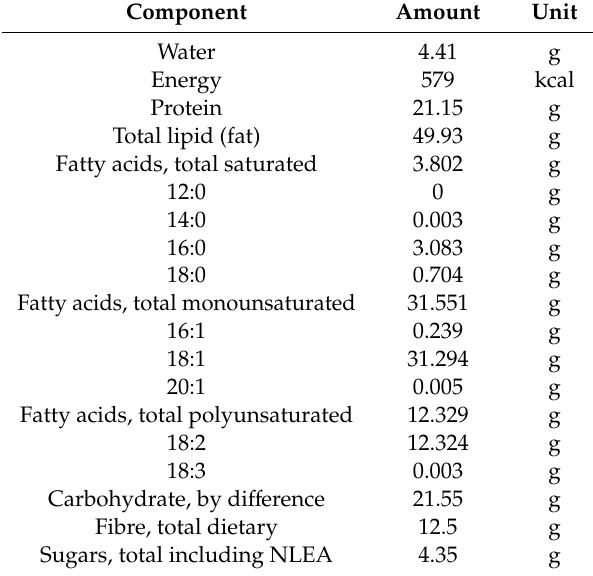
Table 1. Specific nutritional information for a “Marcona almond” (data from Survey (FNDDS), 2019)